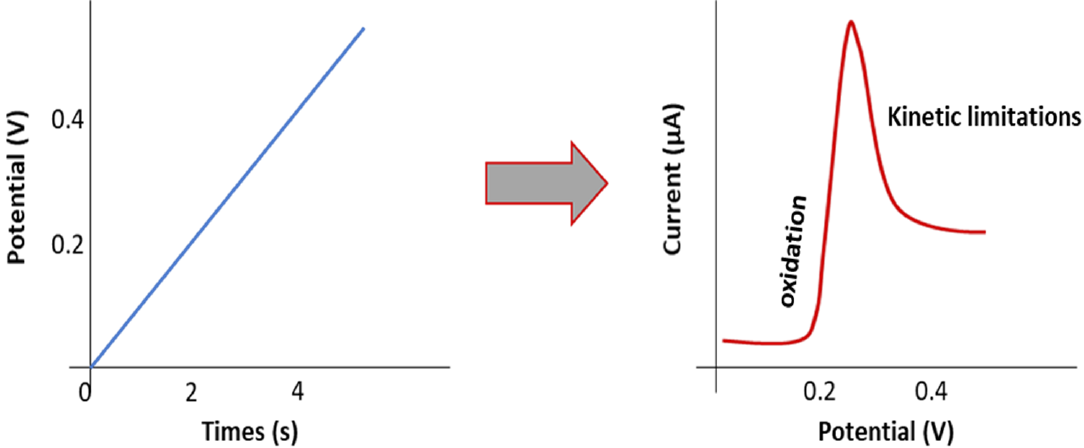
Figure 2. Scheme representing the principle of the LSV method .